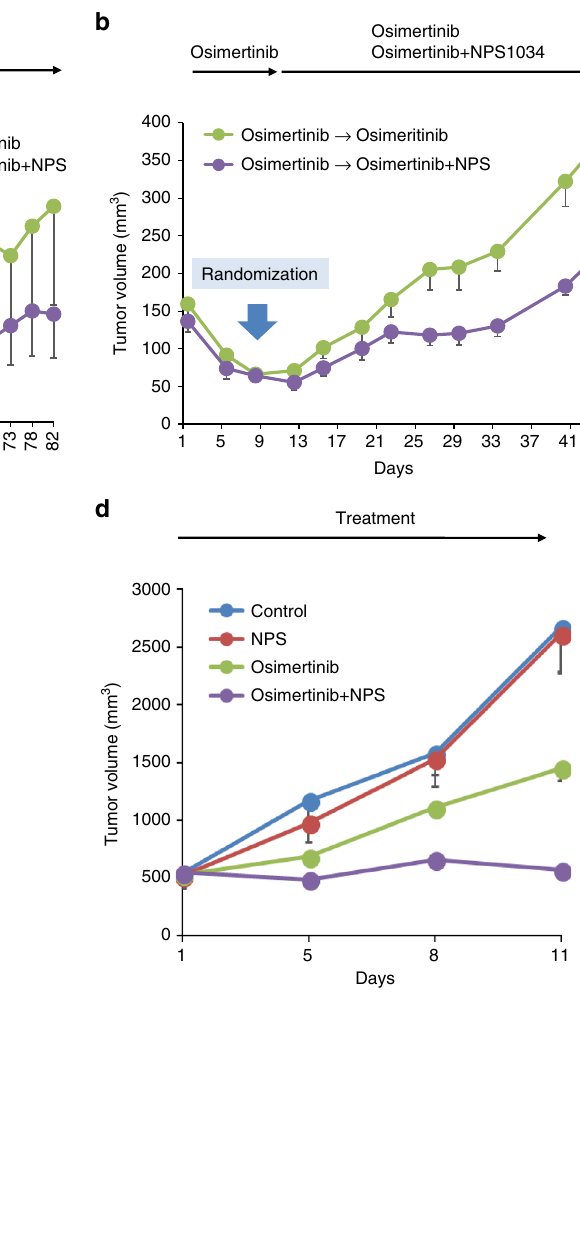
including weight loss, were observed during these treatments (Supplementary Figure 16C). In treatment during the tolerant phase, all PDX tumor-bearing mice were initially treated with only osimertinib and the tumor sizes increased within 1 week (Fig. 7e). On day 8, the mice were randomly divided into two groups. The group of mice with PDX tumors treated continuously